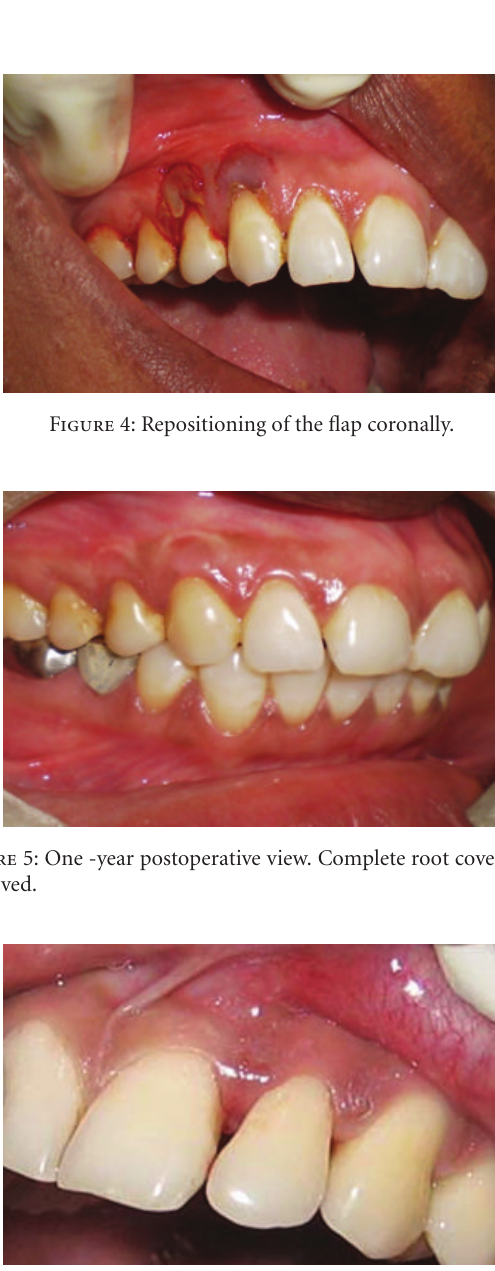
Figure 6: Blunting of interdental papilla between central and lateral incisor.